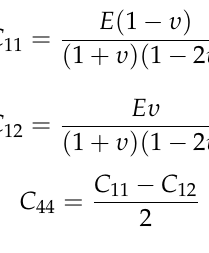
Figure A3. Average values of Young’s modulus (GPa) in box plot representation at different temperatures in degrees Celsius. Different colors in the figure represent different temperatures and their corresponding box plots. The elements of the stiffness matrix ( C 11 , C 12 , and C 44 ) for isotropic elements are calculated from Equations (A20)–(A22) [33,34].